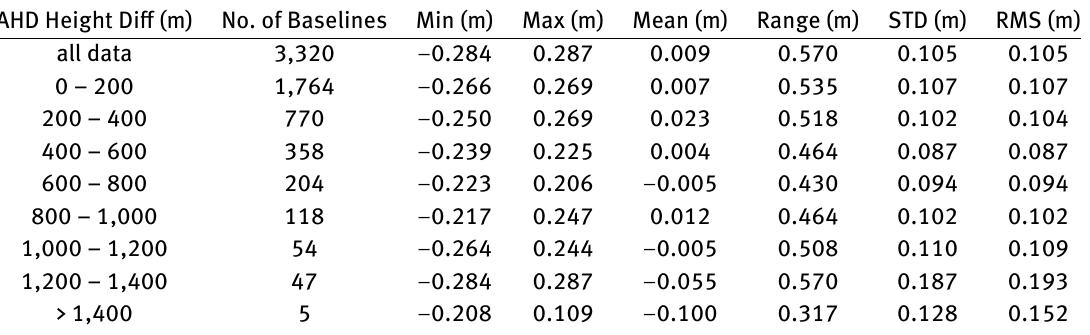
Table 2: Mid Hunter verification: Descriptive statistics of the residuals between AUSGeoid98-derived and oflcial AHD height differences as a function of AHD height difference.